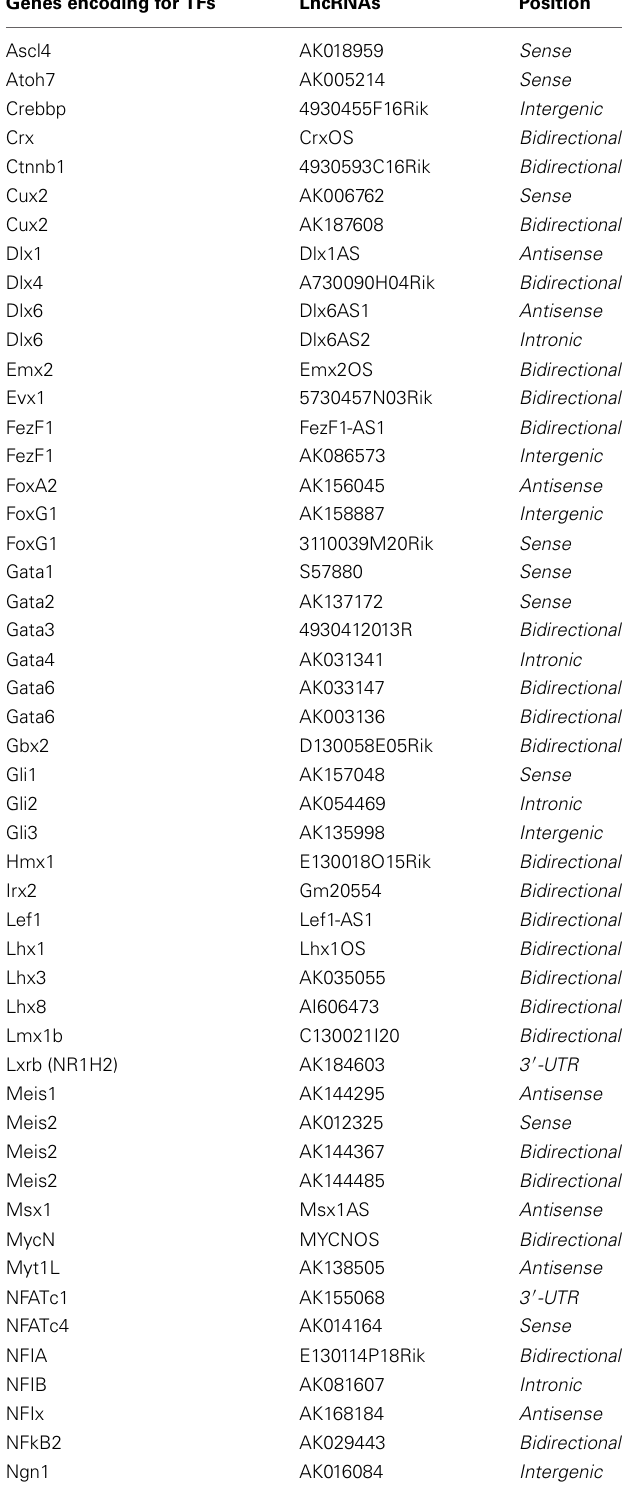
Table 1 | List of genes encoding TFs with critical roles in brain development that also contain lncRNA genes in close proximity to their genomic loci ( <